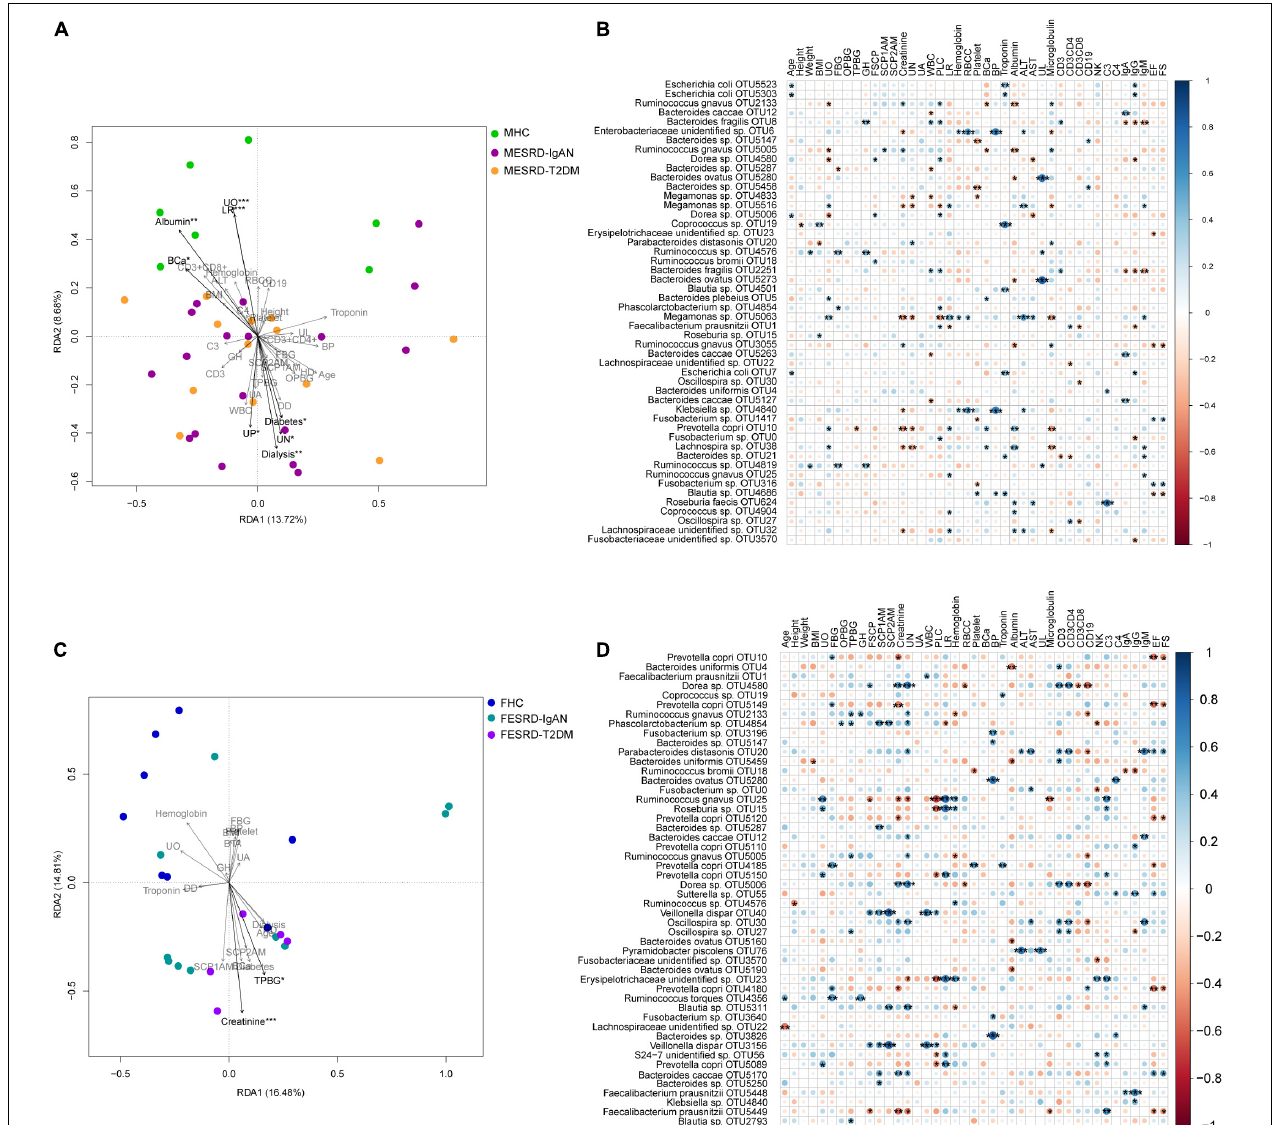
FIGURE 4 | Correlation between physical, blood, and urine indices of volunteers and their fecal microbiota compositions. (A,C) Tb-RDA profile showing the correlation between physical, blood, and urine indices of male and female volunteers and their fecal microbiota OTU compositions. (B,D) Bubble charts showing the Pearson correlation between physical, blood, and urine indices of male and female volunteers and the top 50 dominant OTUs in their fecal microbiota. FBG, fasting blood glucose; OPBG, one-hour post-prandial blood glucose; TPBG, two hours post-prandial blood glucose; FSCP, fasting serum C-peptide; SCPO, serum C-peptide one hour after meal; SCPT, serum C-peptide two hours after meal; RBCC, red blood cell count. *, p < 0.05; **, p < 0.01; ***, p <